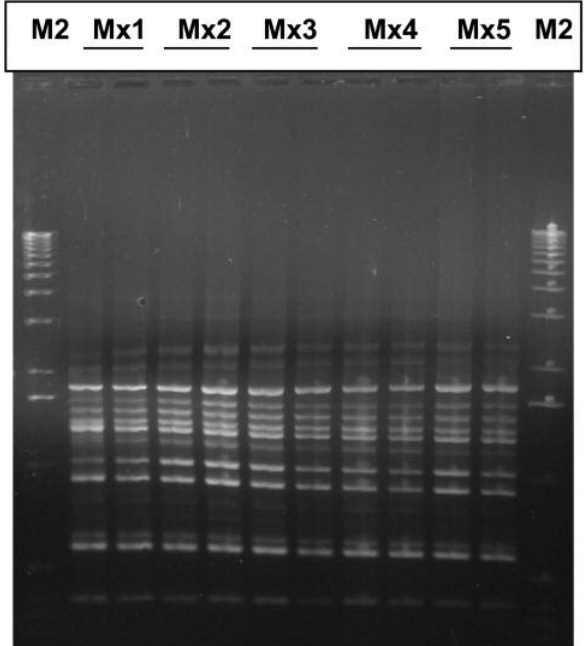
Figure 3 RAPD amplification profiles of five individual plants belonging to “Mavroschinos” using primer OPG2 and a hot-start procedure. Duplicate samples from each individual were elec- trophoresed in a 1.8% agarose gel (1X TAE buffer). Lanes: M2, 1.0 kb- DNA ladder. Mx1, Mx2, Mx3, Mx4 and Mx5 are individual “Mavroschinos” plants.